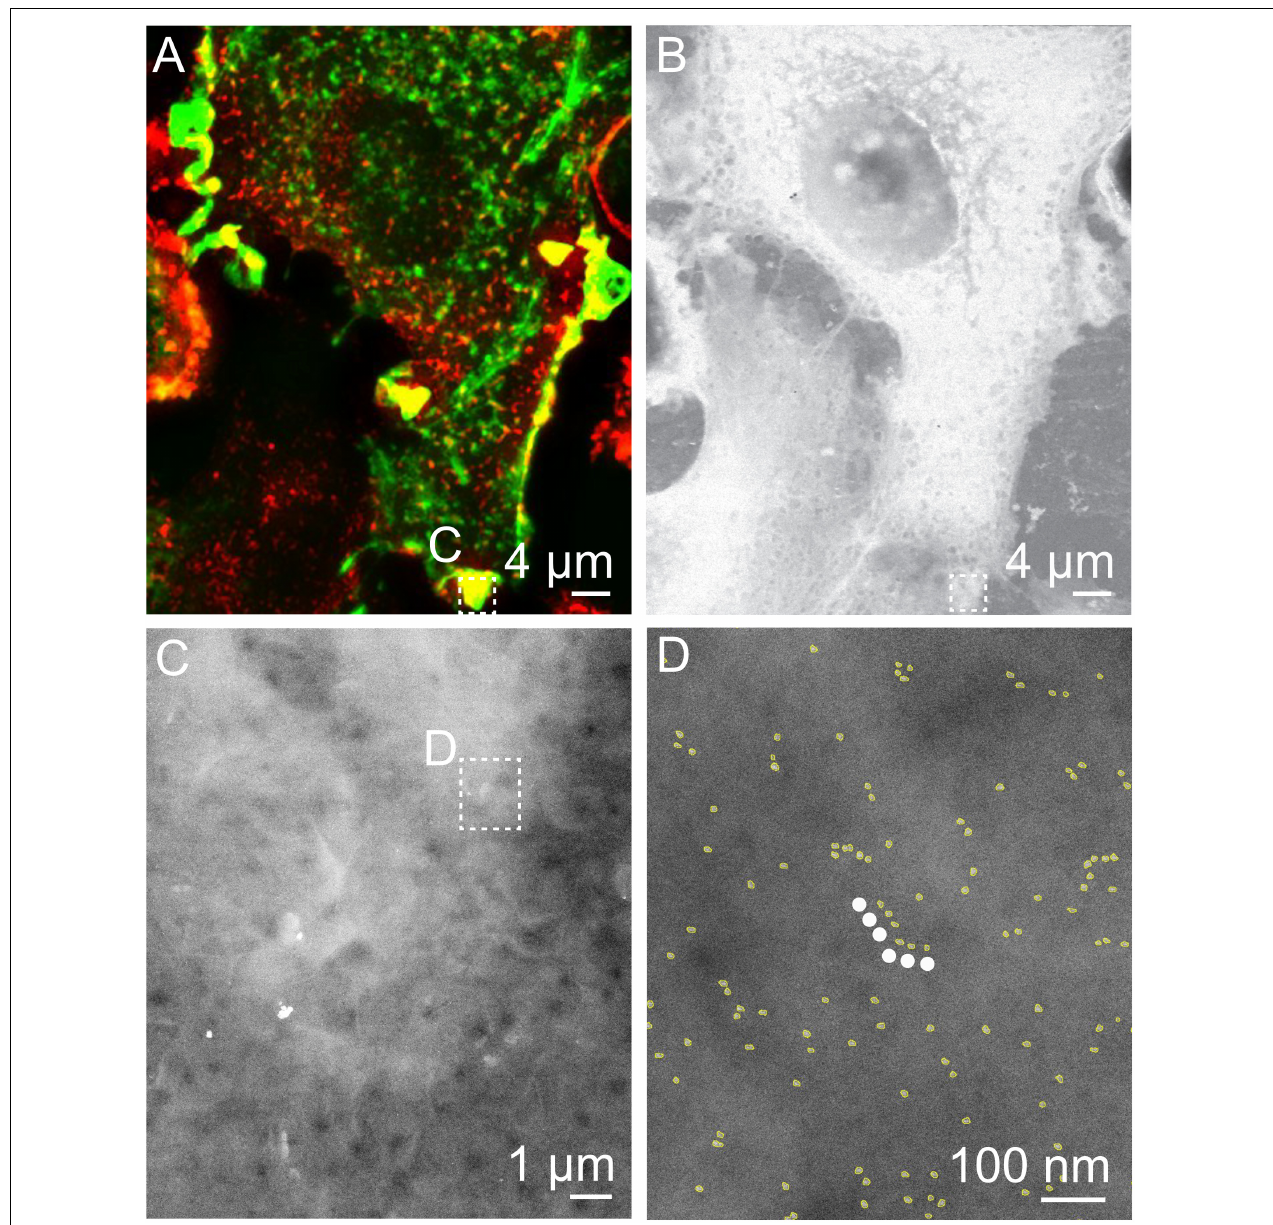
FIGURE 5 | Correlative FM and STEM of QD-labeled ErbB2 on whole breast cancer cells revealing linear QD-chains in actin rich region. (A) Cropped fluorescence micrograph of a SKBR3 breast cancer cell showing cellular actin-GFP in green and QD-labeled membrane ErbB2 in red. Areas where both signals overlap appear yellow. (B) Corresponding STEM micrograph acquired at the same spot ( M = 1,000 × ). (C) STEM micrograph of region marked in A. B at M = 30,000 × . (D) Region selected from C imaged at M = 100,000 × . Automatically detected QD-labels are marked in yellow to enhance the visibility. The white dotted line marks a